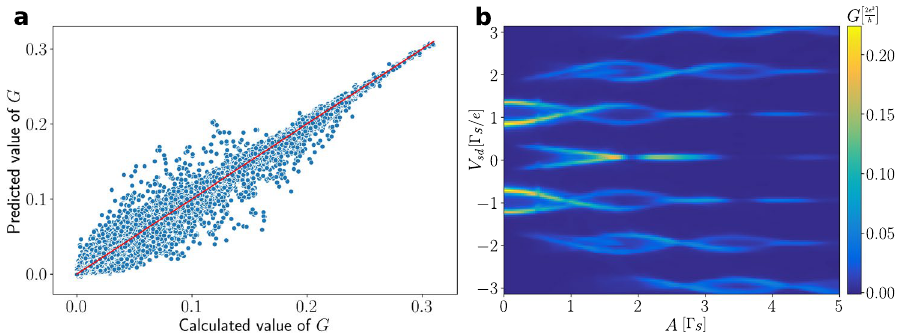
Figure 12. Neural network data. ( a ) Comparison of the differential conductance predicted by the neural network versus its value determined by the microscopic calculations. The red line y The conductance map generated by the neural network, reproducing the results presented in Fig. 9a.